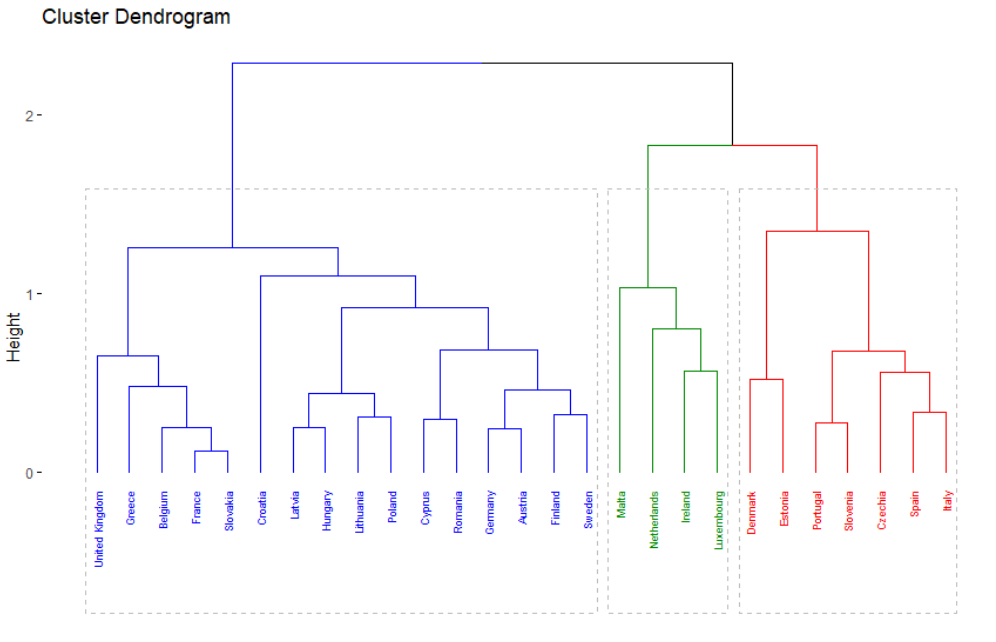
Figure 5. Dendrogram for the years 2004-2010. Source: author’s own study carried out using the ‘factoextra’ package in R environment (Kassambara and Mundt, 2017).